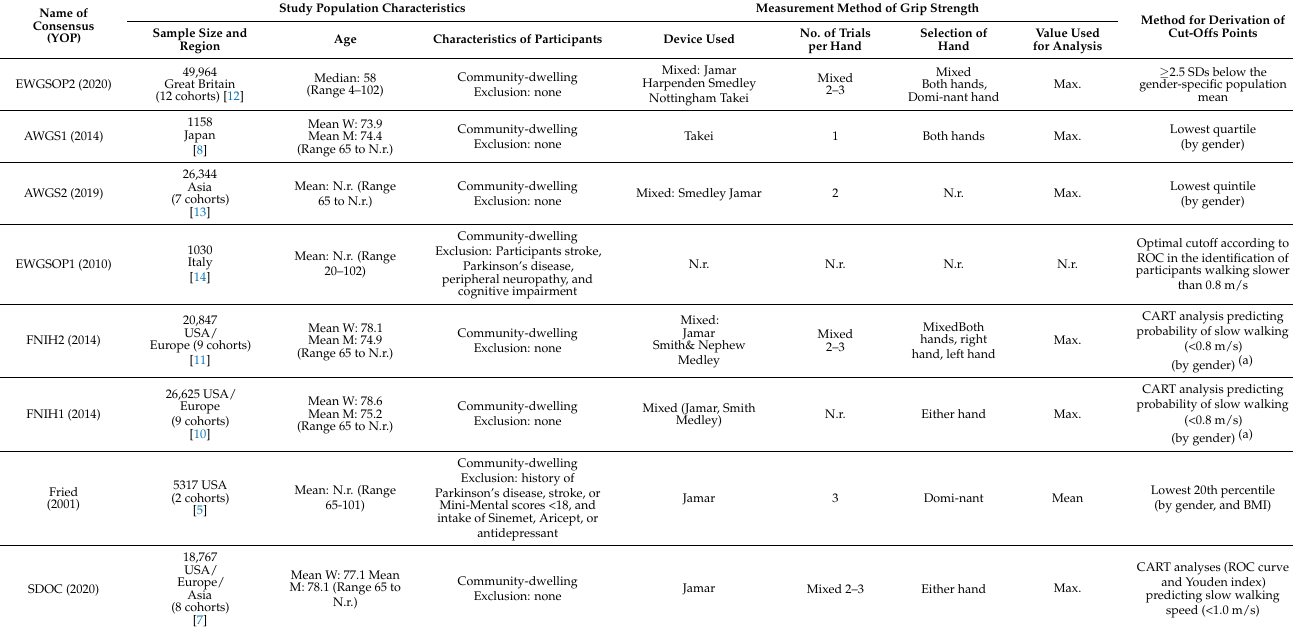
Table 1. Characteristics of derivation studies used for consensus definition of low grip